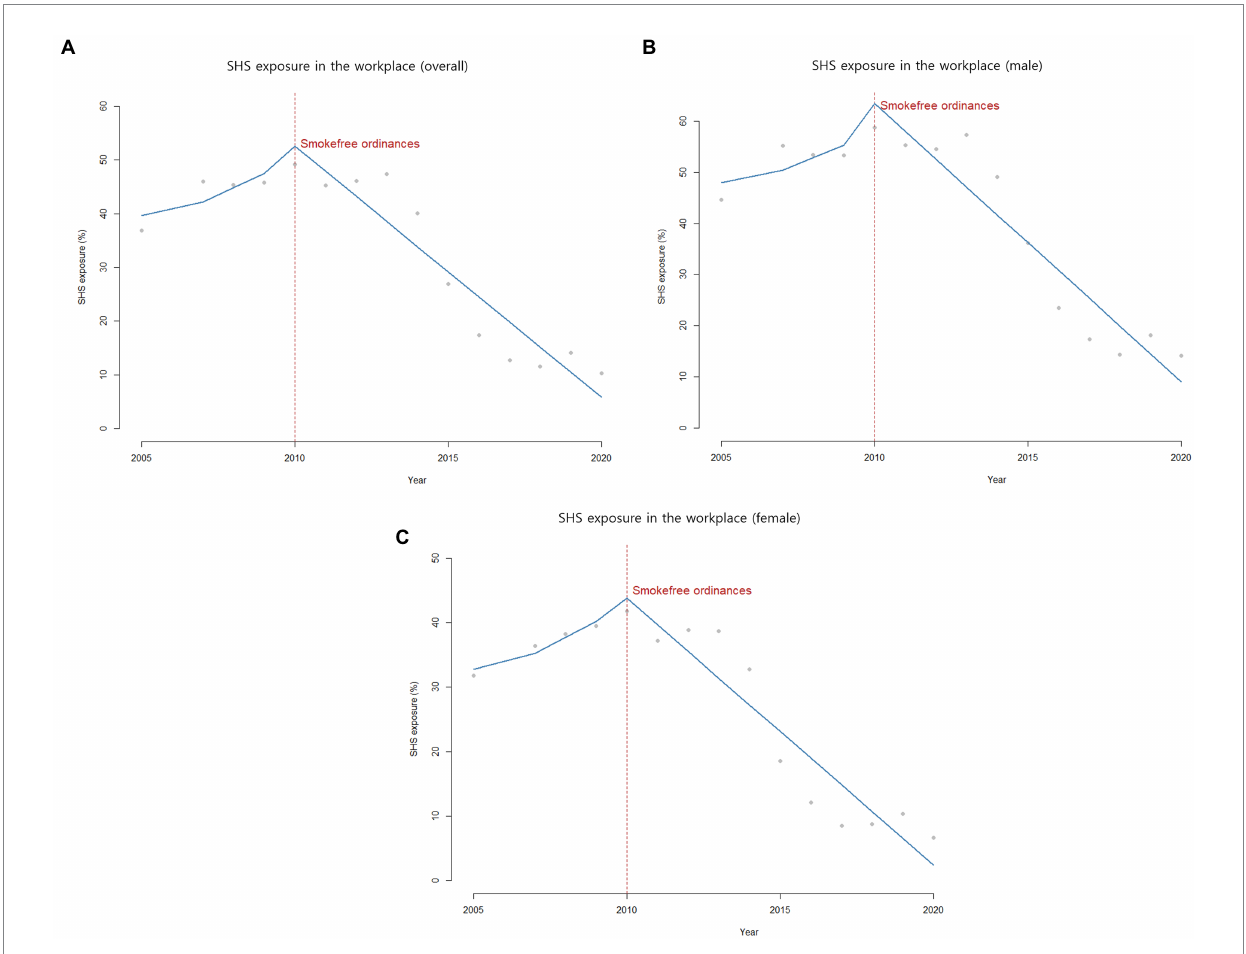
FIGURE 1 SHS exposure in the workplace among adults in ROK